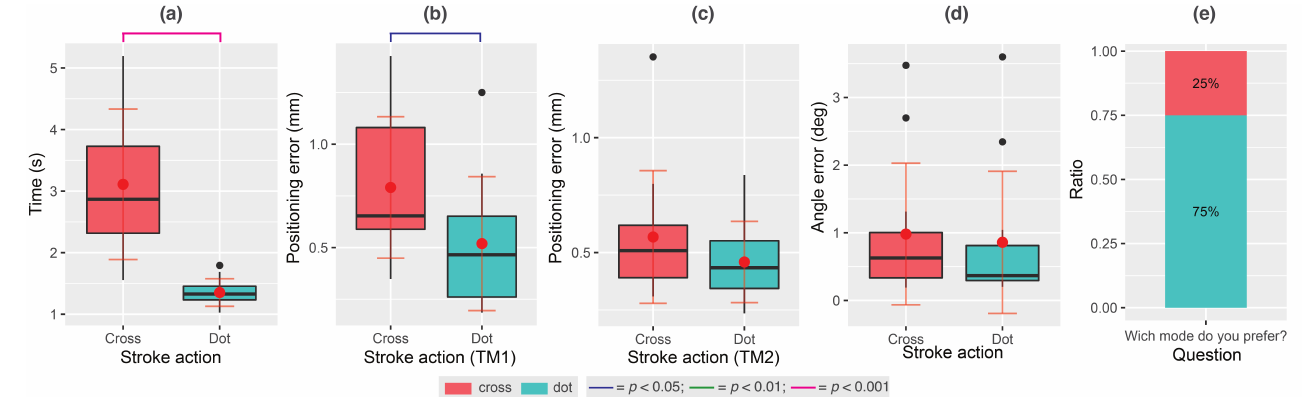
Figure 6. ( a ) Task completion time. ( b ) Position error for target marker 1 (TM1). ( c ) Position error for target marker 2 (TM2). ( d ) Angle error. ( e ) Preferred stroke